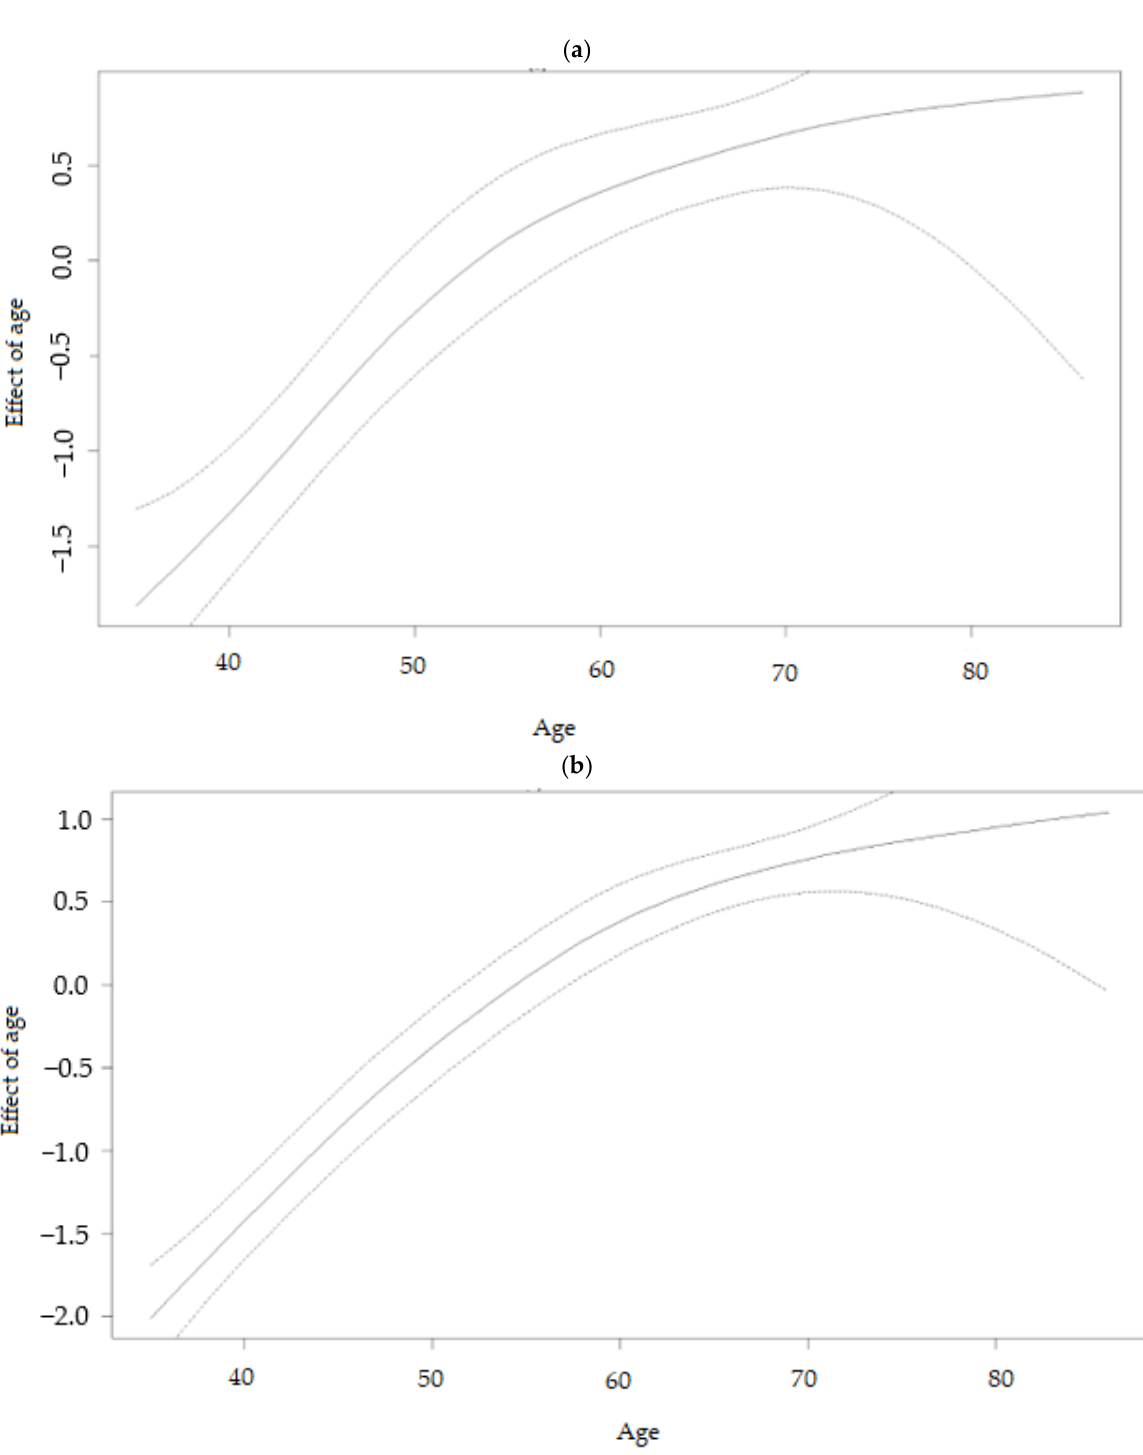
Figure 5. ( a ) Non-linear effects of age on the log-odds of diabetes (posterior means with the 97.5% credible interval). ( b ) Non-linear effects of age on the log-odds of hypertension (posterior means with the 97.5% credible interval).